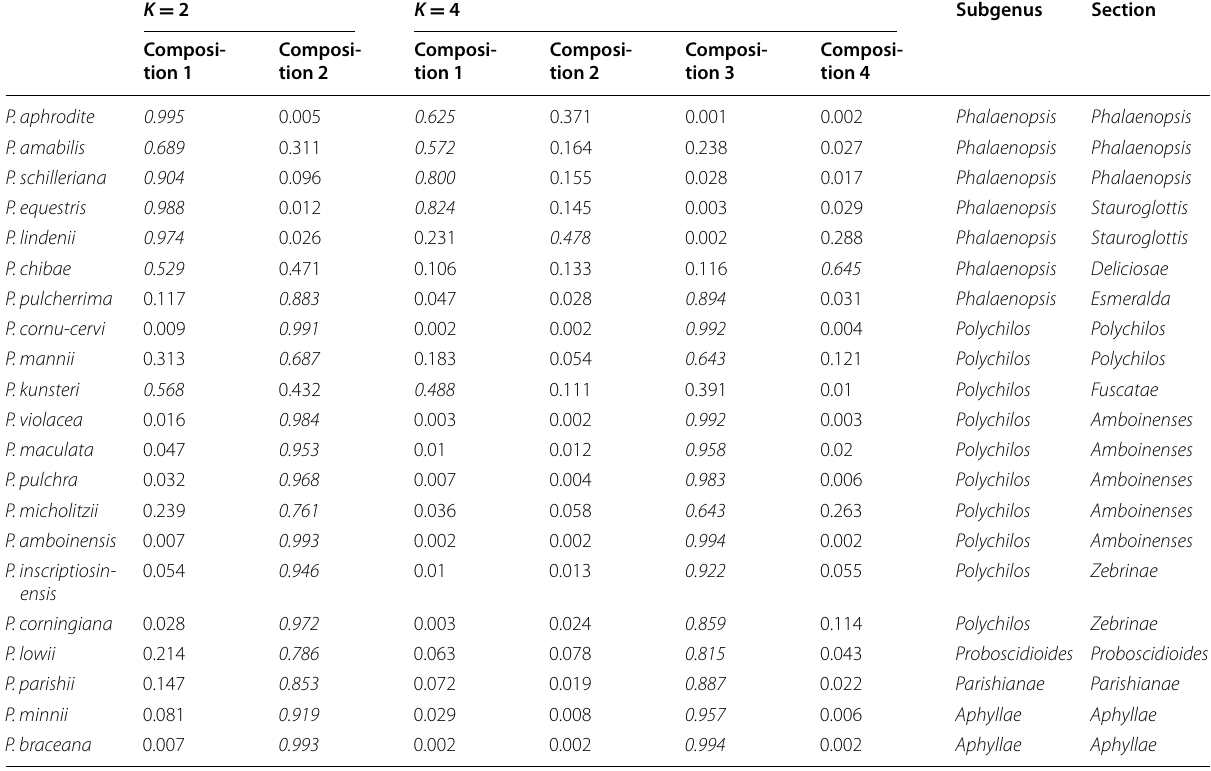
Italic values indicate major component of the species